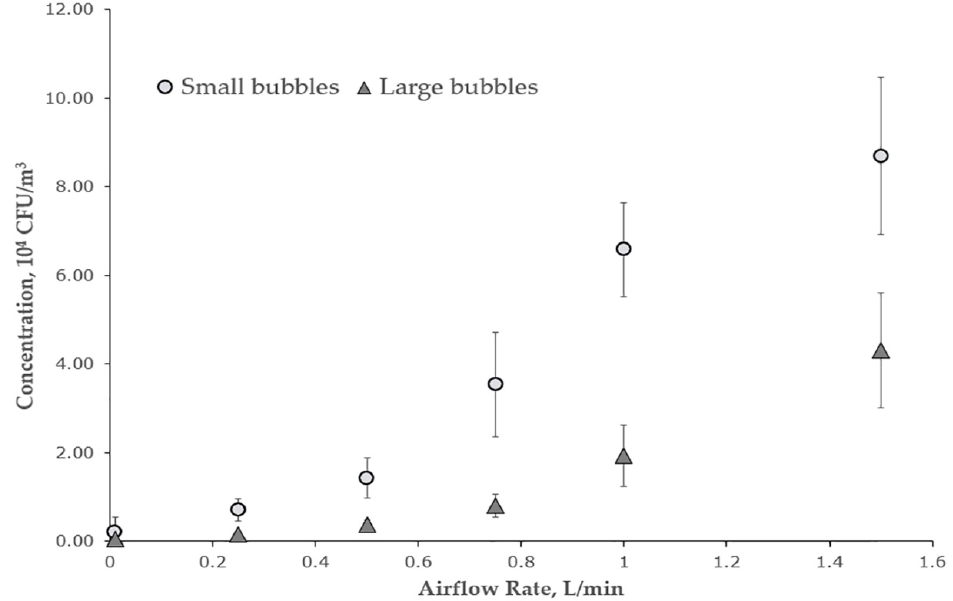
Figure 3. Influence of the airflow rates on the bioaerosol release. The error bars represent STDEV of at least three experimental runs.